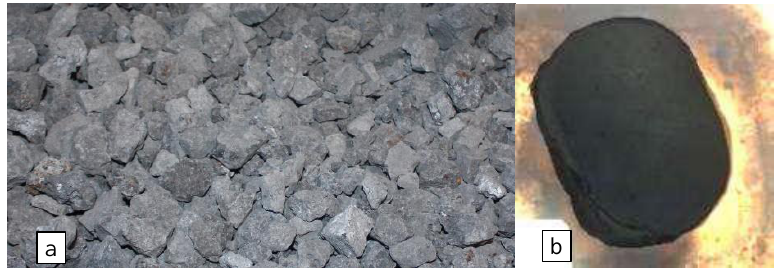
Figure 3. Slag as received ( a ) and sintered slag pebble ( b ).